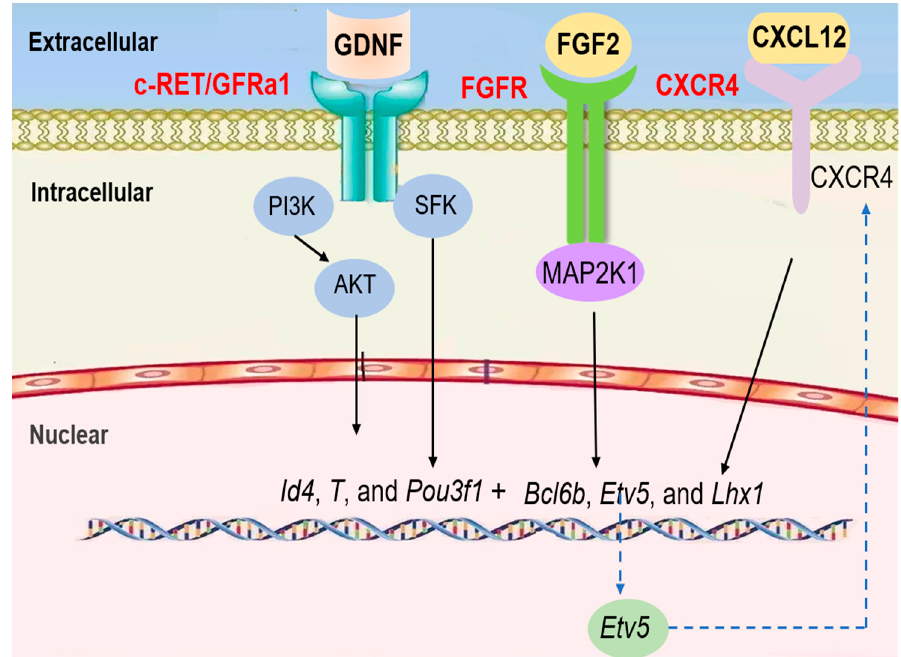
Figure 3. Current understanding of the signaling pathways regulating the mitosis of SSCs in mouse testes.